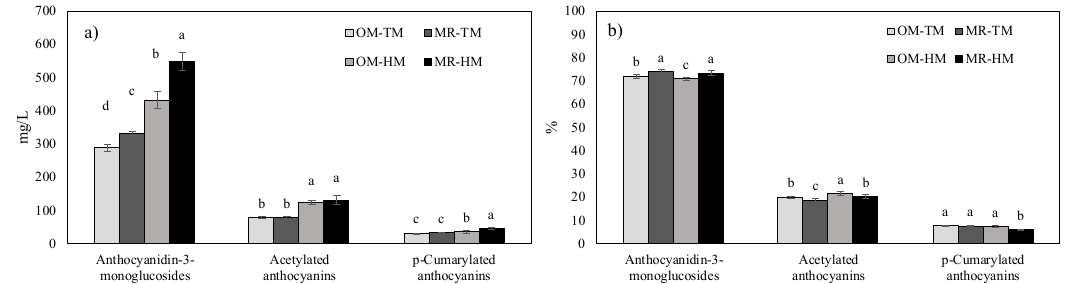
Figure 3. Concentration ( a ) and proportion ( b ) of anthocyanidin-3-monoglucosides, acetylated anthocyanins, and p-coumarylated anthocyanins. Average of nine wines ± standard deviation. Different letters indicate statistical differences ( p < 0.05). OM-TM: original must and traditional maceration; MR-TM: must replacement and traditional maceration; OM-HM: original must and hot